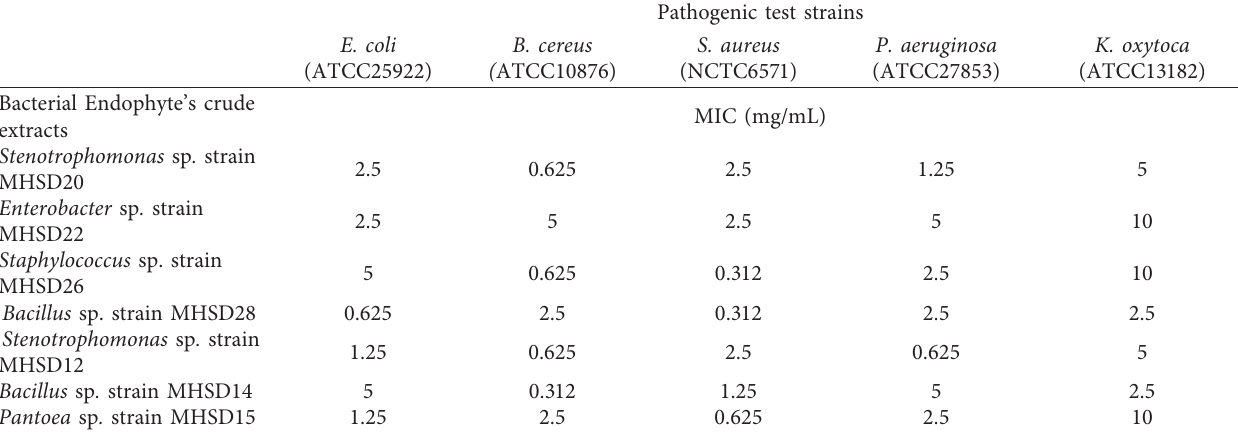
Table 3: Minimum inhibitory concentrations of crude extracts of secondary metabolites from bacterial endophytes associated with Dicoma anomala.